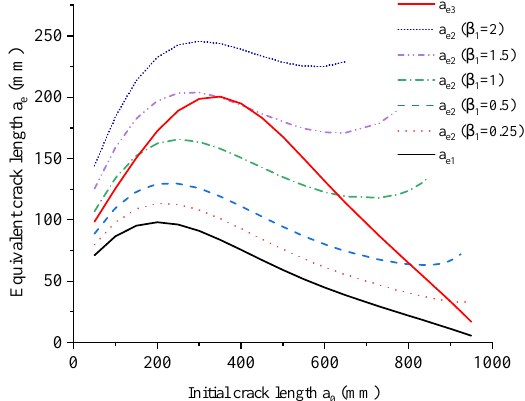
Figure 4. Equivalent crack length a e versus initial crack length a 0 for different discrete number β 1 when d max = 150